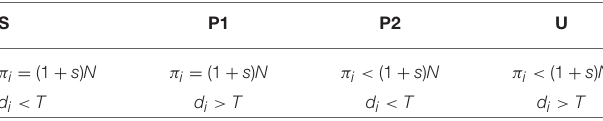
TABLE 2 | Degrees of satisfaction according to the fulfilment of social and strategical objectives. S